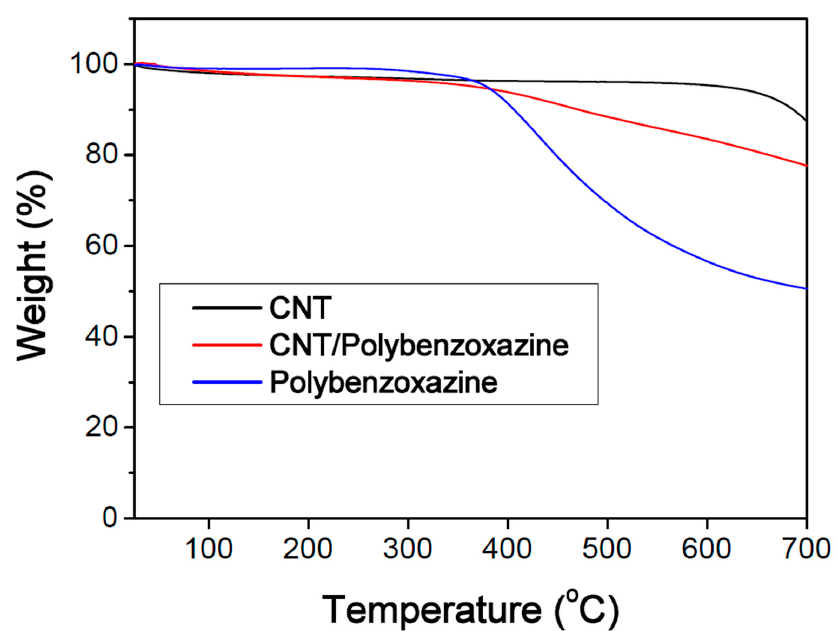
Figure 7. Thermogravimetric analysis (TGA) traces of crude CNTs, polybenzoxazine and the CNT/polybenzoxazine composite under N 2 . Table 1. Comparison of various durable superhydrophobic surfaces. Materials